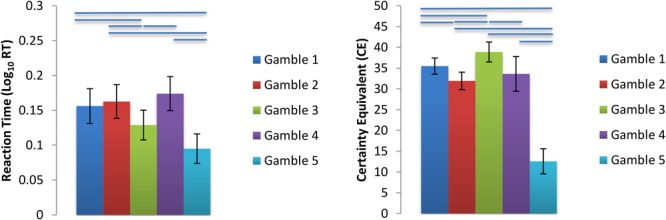
Log10 Transformed Mean Reaction Times and CE s for each gamble. Gamble 1 = Baseline, Gamble 2 = Control Probability of Loss, Gamble 3 = Control Variance, Gamble 4 = Control Maximum Possible Loss, Gamble 5 = Orthogonalization Condition. Bars above gamble pairs denote significance at p < 0.05. For further statistics see Supplementary Tables S2–S7 and Supplementary Figure S3 in the Supplementary Materials.